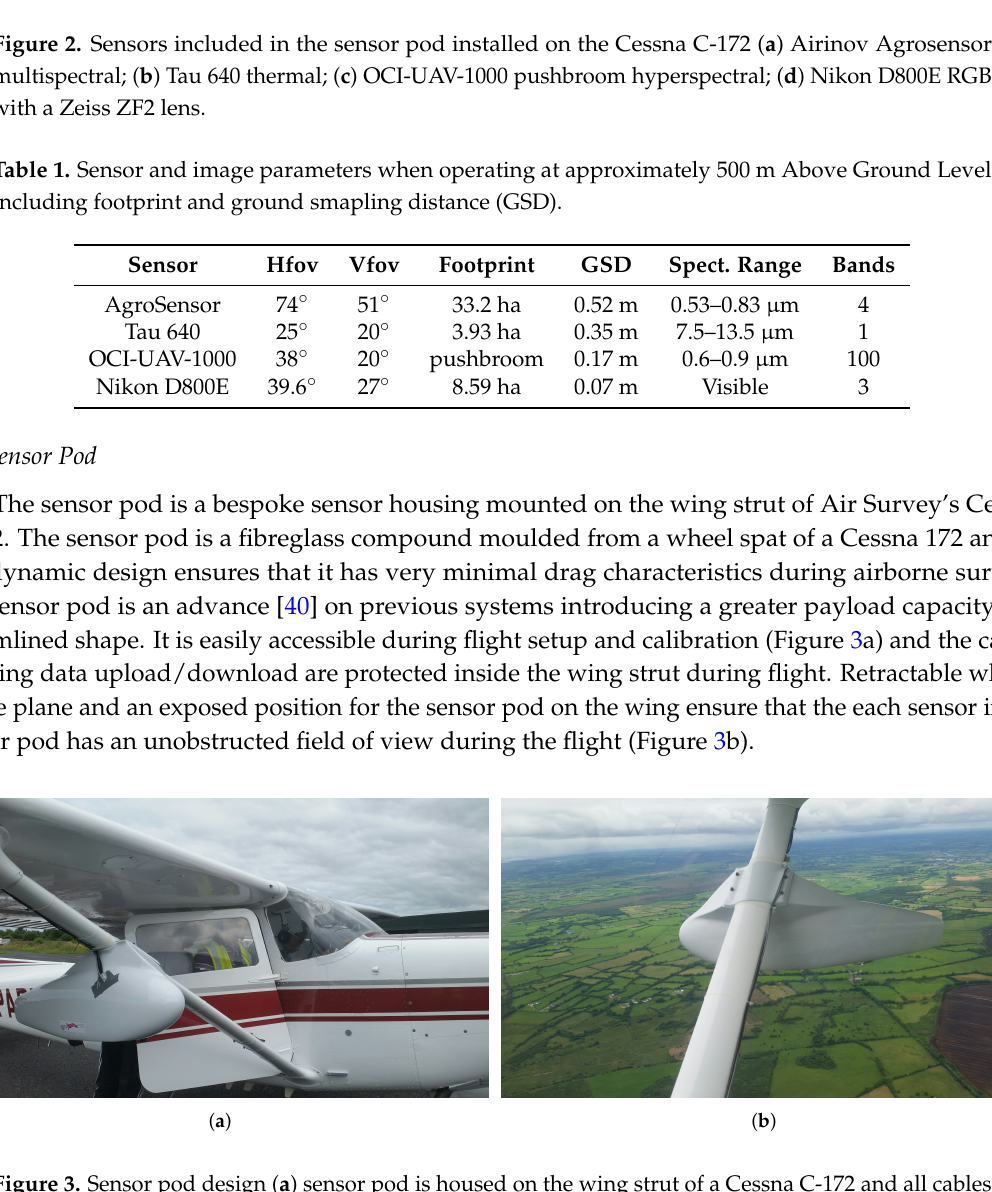
Figure 3. Sensor pod design ( a ) sensor pod is housed on the wing strut of a Cessna C-172 and all cables controlling upload/download are housed internally, protected from environmental effects; ( b ) exposed position on the wing strut results in an unobstructed view below the